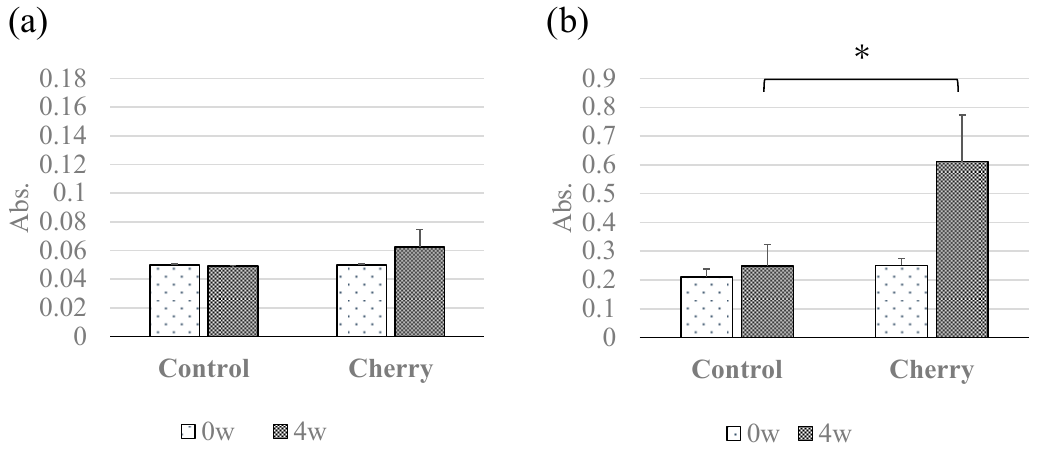
Figure 2. Effect of percutaneous sensitization with cherry extracts on cherry-specific antibody levels in mice sera. Cherry- protein-specific IgE levels ( a ) and IgG1 levels ( b ) in control and cherry groups at 0 and 4 weeks were determined using ELISA performed with cherry protein-coated plates. The ELISA data is presented in absorbance values (Abs). Absorbance data are presented as means ± standard deviations (SD); control group ( n = 7), cherry group ( n = 7). * p <